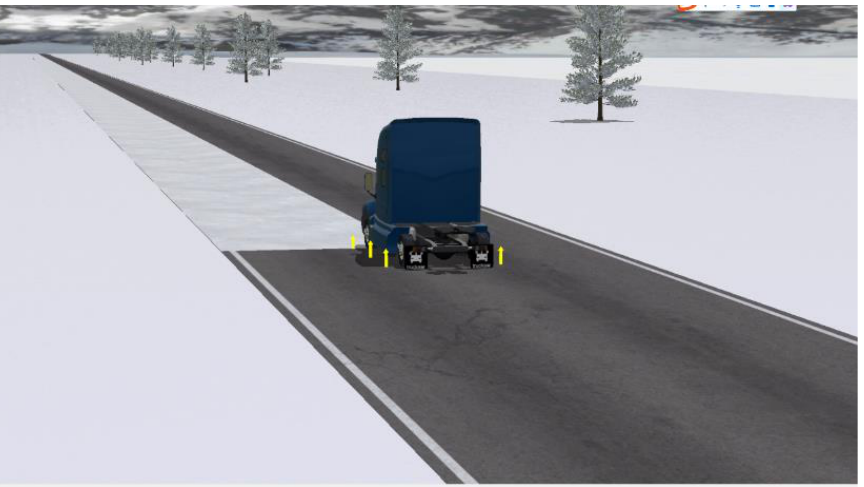
Figure 8. Split mu straight road. The yellow arrow represents the force on the wheel in the z-axis